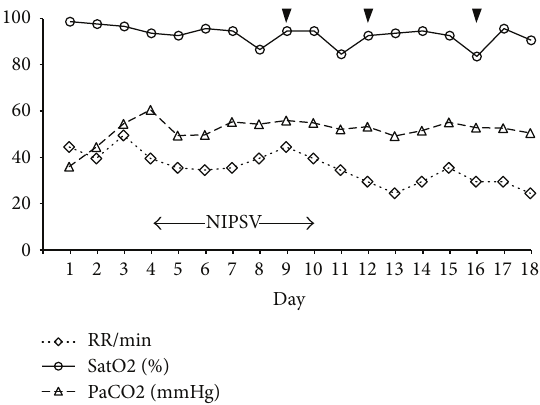
Figure 2: Changes in SatO2 and PaCO2 and respiratory rate (RR) in relation to the application of noninvasive pressure support ventilation (NIPSV) and 3 doses of etanercept 25 mg administered subcutaneously (black